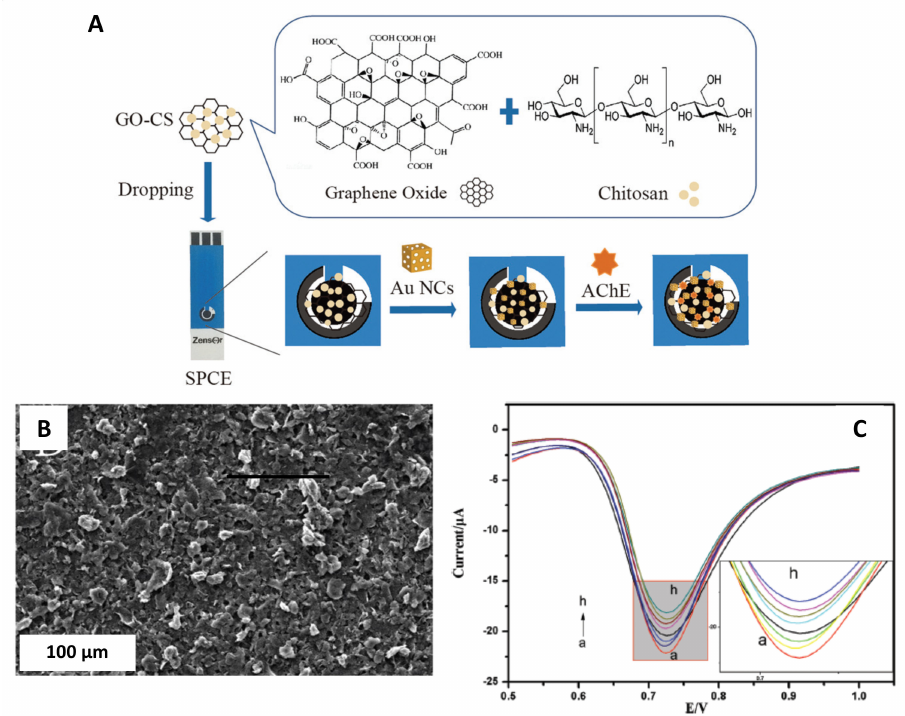
Figure 11. ( A ) Schematic process to construct AChE sensor. ( B ) SEM micrograph of the AuNCs/GO- CS nanocomposite. ( C ) DPV obtained for AChE/AuNCs/GO-CS/SPCE in PBS buffer pH 8.0 with 1.0 mM ATCl after inhibition with chlorpyrifos (0.01, 0.1, 1, 5, 10, 50, 100, and 500 µ g · L − 1 ) for 12 min. Reproduced with permission of Yao et al., New Journal of Chemistry; published by The Royal